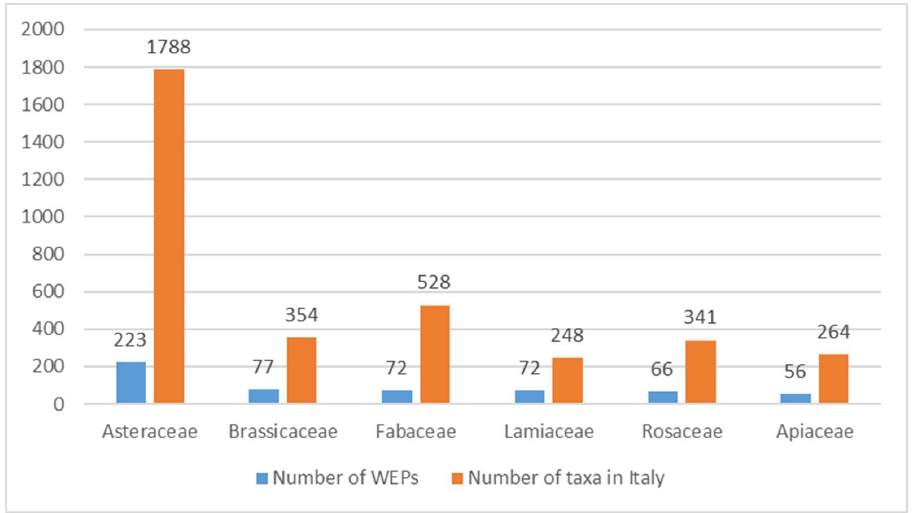
Figure 3. Number of Wild Edible Plants (WEPs) recorded (blue column) and total number of taxa in Italian flora of the most frequent families in the Database AlimurgITA.